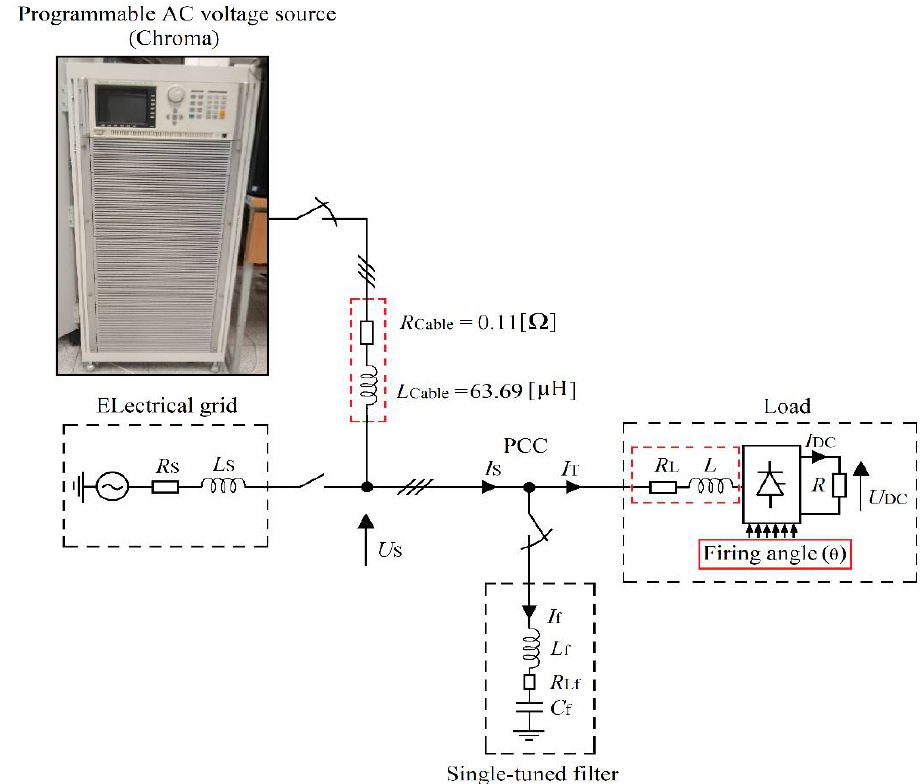
Figure 21. Experiments with the programmable voltage source Chroma: equivalent circuit of the laboratory model.